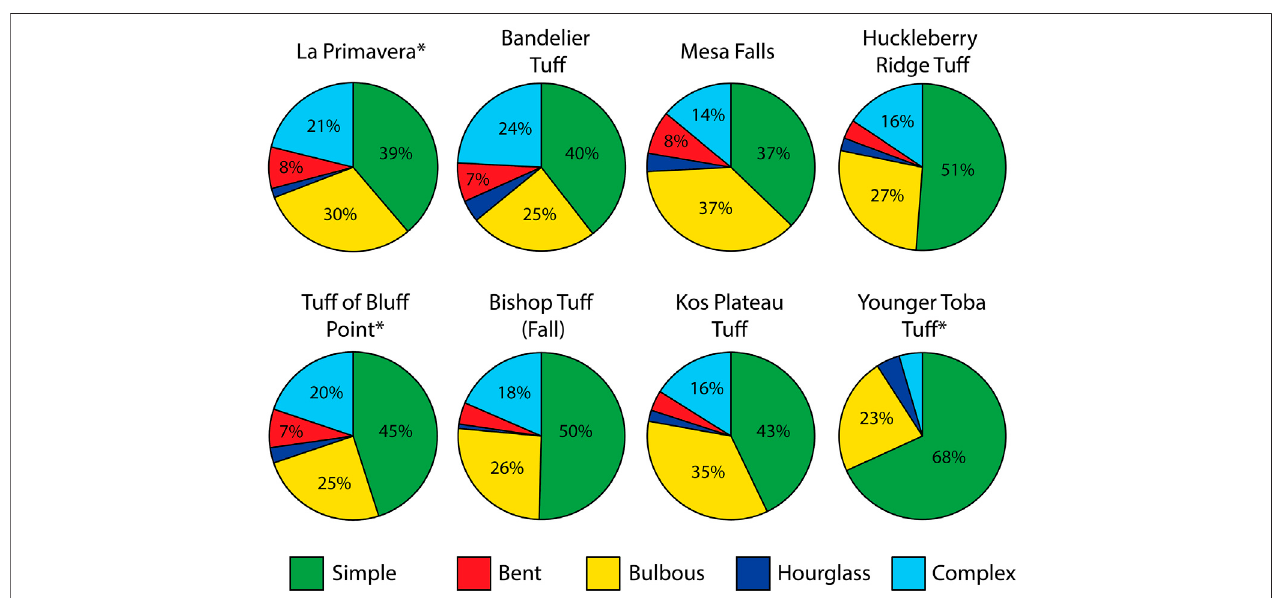
FIGURE 5 | Relative abundance of embayment morphologies. Samples from ignimbrites indicated with an asterisk.